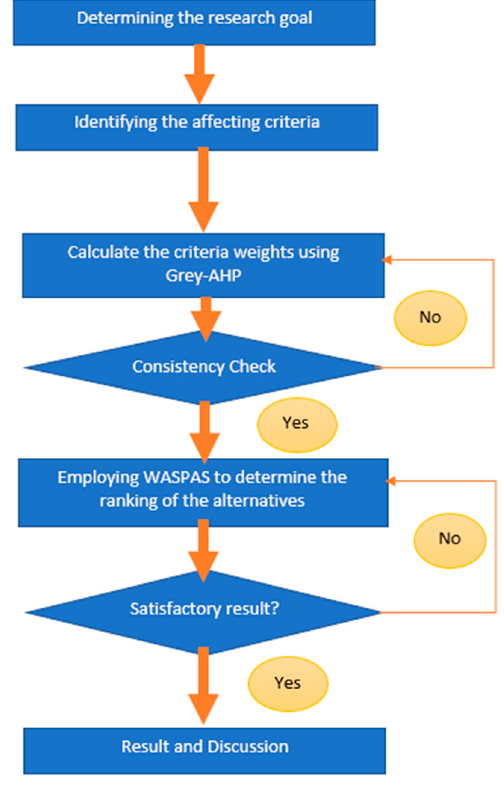
Figure 2. Research Process.